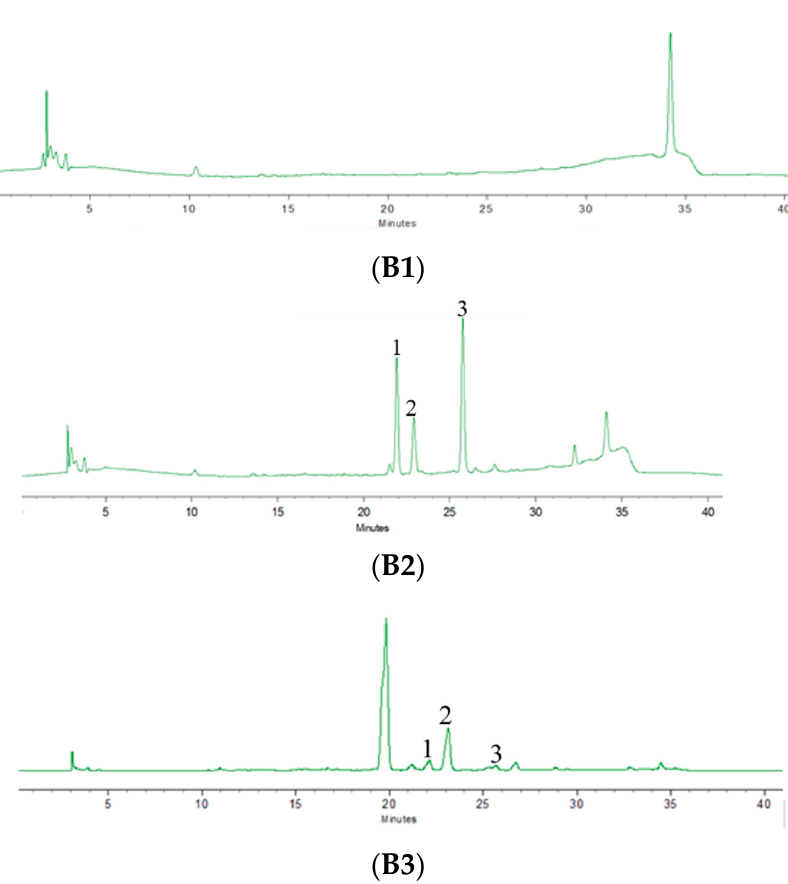
Figure 5. Chromatogram chart. ( A ) UPLC-MS/MS chromatograms of notoginsenoside R1 (R1). Blank rat plasma ( A1 ); Rat plasma spiked with R1 ( A2 ); Plasma sample after oral administration of R1 containing Sodium N-[8-(2-hydroxybenzoyl)amino]caprylate (SNAC) ( A3 ). 1. R1, 2. IS. ( B ) HPLC chromatograms of salvianolic acids (SAs). Blank Blood ( B1 ); Rat plasma spiked with mixture the standard solution ( B2 ); Plasma sample after oral administration of SAs containing SNAC ( B3 ). 1. Rosmarinic acid, 2. Salvianolic acid B, 3. Salvianolic acid A.